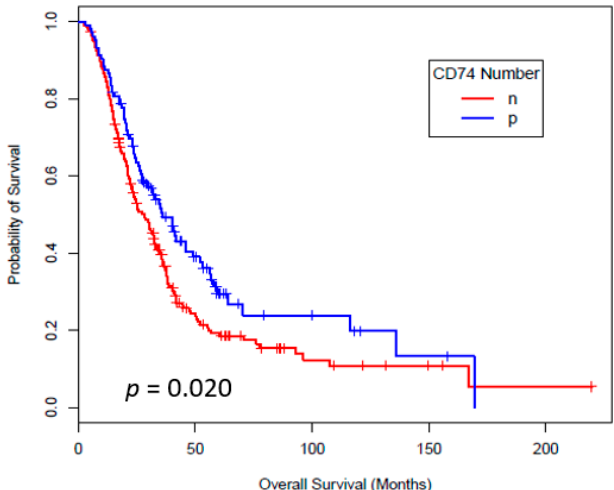
Figure 1. Overall Survival by CD74 Number. Clinical outcomes by CD74 in tumor cells in stage IV melanoma patients in datasets. Kaplan-Meier analysis for OS for the expression by percentage of staining. n = negative ( < 5% cells are positive), p = positive ( =/> 5% cells are positive).